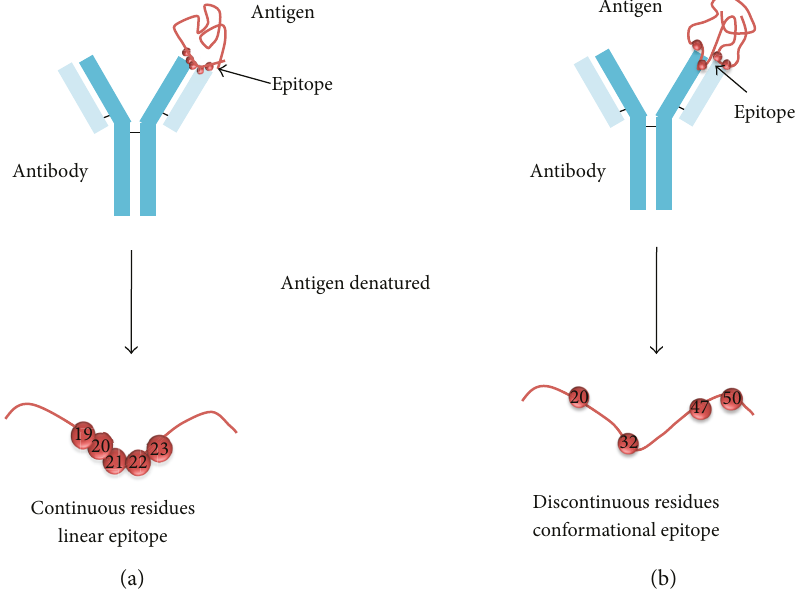
Figure 5: Linear and conformational B-cell epitopes. Linear B-cell epitopes (a) are composed of sequential/continuous residues, while conformational B-cell epitopes (b) contain scattered/discontinuous residues along the